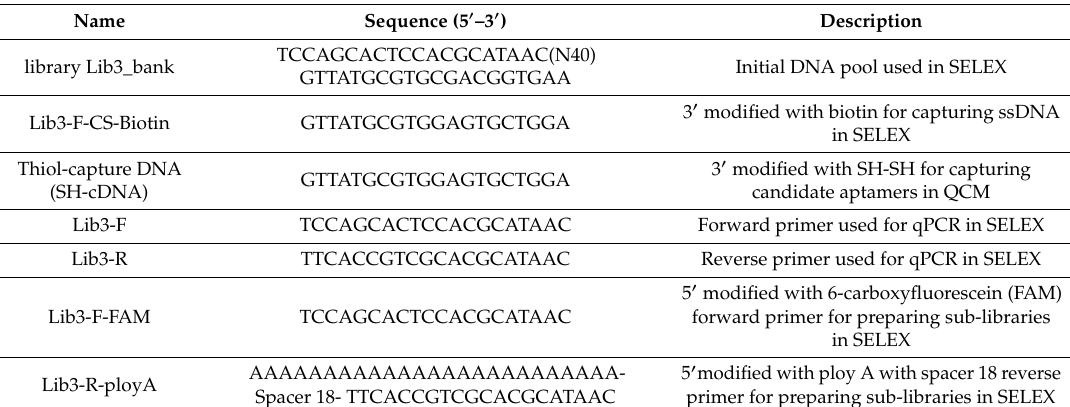
Table 1. Library and primers